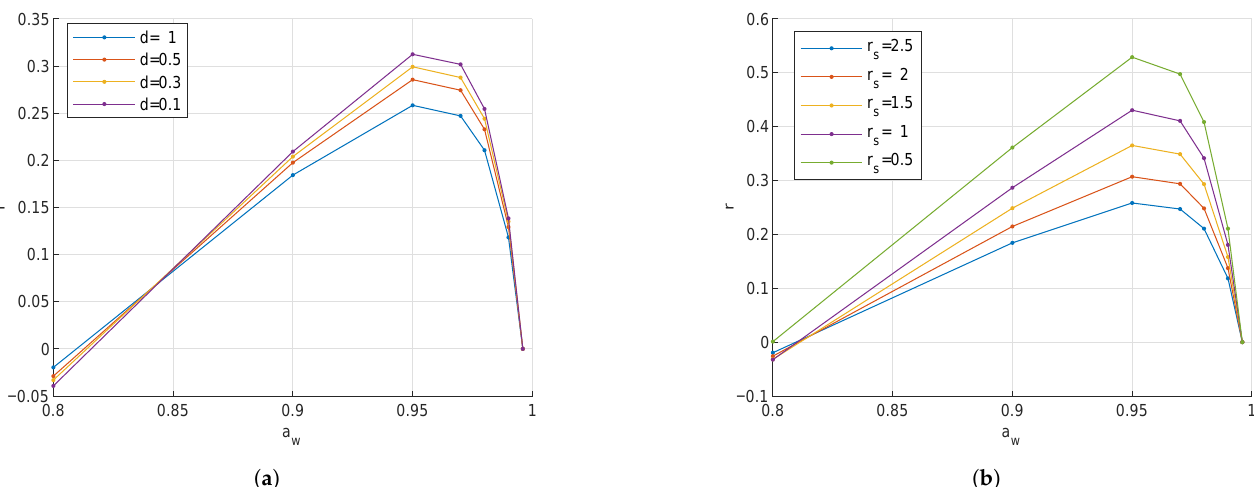
Figure 6. Relative sensitivity analysis of the circular conductance electrode at 1MHz. ( a ) Relative sensitivity r with varying electrode gap: Parameter d is the electrode gap in mm. The radius of the sensing electrode was kept at 2.5mm. The radius of the driving electrode was adjusted to keep the area equal to the sensing electrode area. Reducing the electrode gap increases the sensitivity. ( b ) Relative sensitivity r with varying electrode radius: Parameter r s is the radius of the sensing electrode in mm. The electrode gap was kept at 1mm. The radius of the driving electrode was adjusted to keep the area equal to the sensing electrode area. Reducing the electrode area increases the sensitivity.